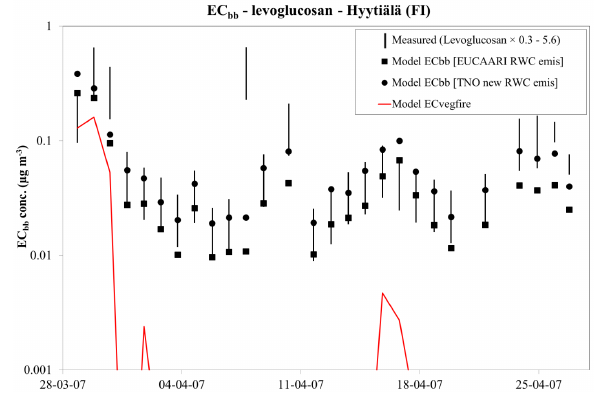
Fig. 12. Biomass burning EC (EC bb ) from wintertime source- Fig. 12: Biomass burning EC (EC bb ) from winter time source apportionment studies in 1 apportionment studies in Scandinavia (Yttri et al., 2011; Szidat et Scandinavia (Yttri et al., 2011; Szidat et al., 2009; Genberg et al., 2011) compared to model 2 al., 2009; Genberg et al., 2011) compared to model calculations us- calculations using different emission inventories. Observed EC bb -bars represent 10 th and 90 th 3 ing different emission inventories. Observed EC bb bars represent percentiles. Note the logarithmic scale on the y-axis. 4 10th and 90th percentiles. Note the logarithmic scale on the y axis. tial part of the missing EC.